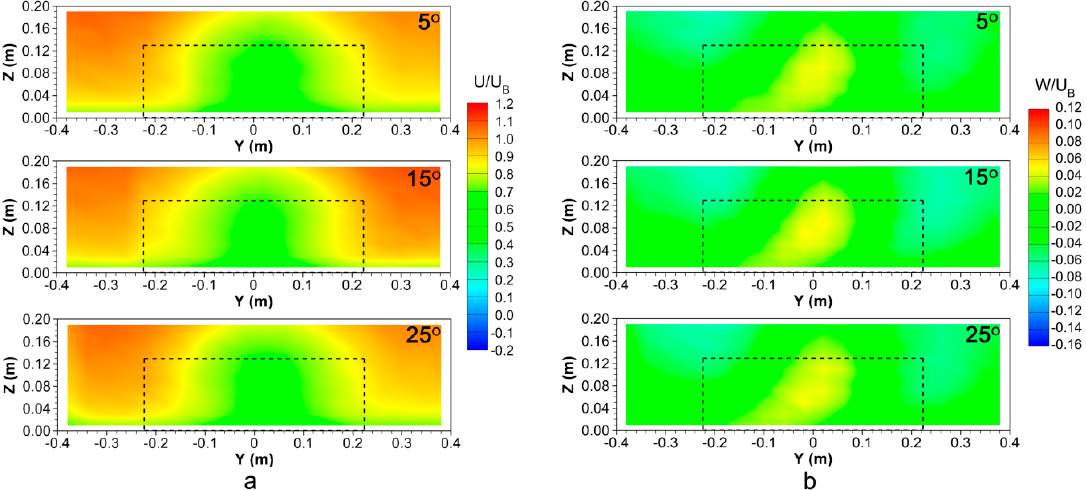
Figure 8. Spatial distributions of ( a ) streamwise ( U ) and ( b ) vertical ( W ) air velocities normalised by the air velocity at building height ( U B ) at Plane 2 for roof slopes of 5°, 15°, and 25°. Black dash lines indicate the profile of the scaled model.